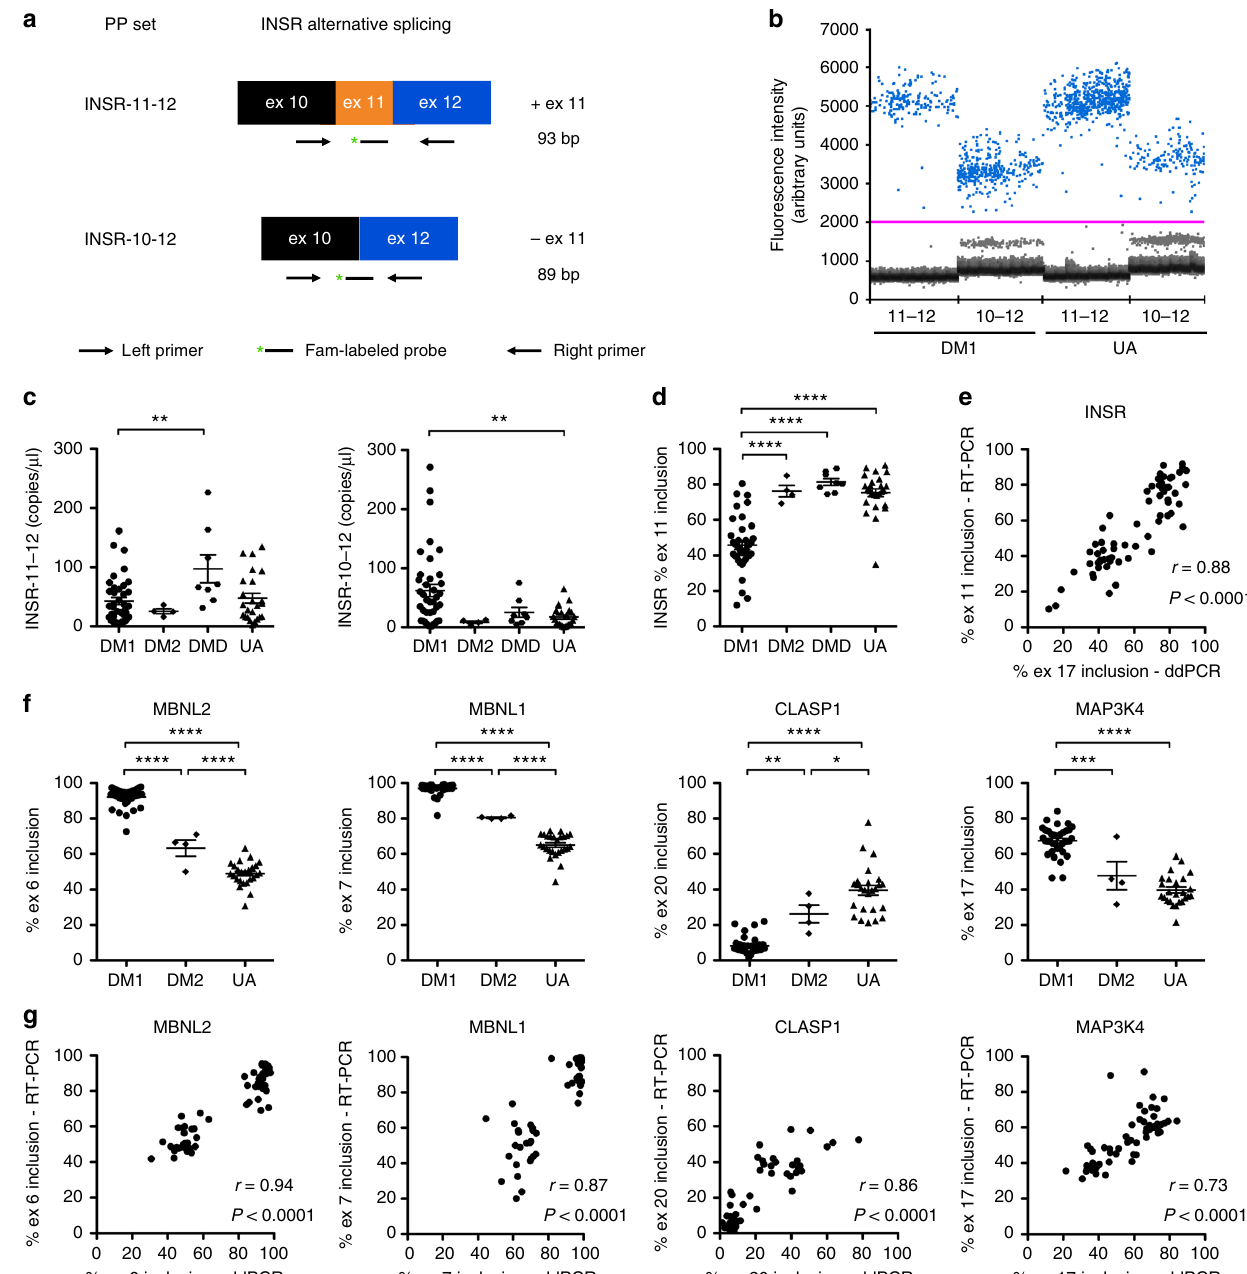
Fig. 5 Droplet digital PCR (ddPCR) analysis of alternative splicing in human urine exRNA. We used ddPCR to examine splicing of INSR exon 11 in urine exRNA samples from DM1 ( N = 37), DM2 ( N = 4), DMD/BMD ( N = 8), and UA controls ( N = 25). a Assay design using separate primer probe (PP) sets to identify exon 11 inclusion (INSR-11-12; amplicon size 93 base pairs, “ bp ” ) and exon 11 exclusion (INSR-10-12; amplicon size 89 bp). b Representative droplet populations in urine exRNA samples from DM1 and UA subjects ( N = 4 each) using each assay (INSR-11-12 and INSR-10-12). c Quanti fi cation of INSR splice products that include exon 11 (left) and exclude exon 11 (right) as copies per microliter cDNA. Individual data points represent the mean of duplicate assays for each sample. Error bars indicate mean ± s.e.m. ** P = 0.0015 (DM1 vs. UA); * P = 0.01 (DM1 vs. DMD). d Calculation of INSR exon 11 inclusion using data in c . Error bars indicate mean ± s.e.m. **** P < 0.0001 (DM1 vs. DMD/BMD) and (DM1 vs. UA) groups. e INSR exon 11 inclusion measured by ddPCR ( x -axis) vs. RT-PCR ( y -axis) in all subjects. The correlation coef fi cient r and P value are shown. f Exon inclusion percentages for MBNL2 exon 6, MBNL1 exon 7, CLASP1 exon 20, and MAP3K4 exon 17. Error bars indicate mean ± s.e.m. **** P < 0.0001 (all four transcripts, DM1 vs. UA), ( MBNL2 and MBNL1 , DM1 vs. DM2), and, ( MBNL1 , DM2 vs. UA); *** mean difference 14.2, 95% CI of difference 6.2 – 22.1 ( MBNL2 , DM1 vs. DM2), and mean difference 20.1, 95% CI of difference 9.0 – 31.2, ( MAP3K4 , DM1 vs. DM2); ** mean difference 17.9, 95% CI of difference 5.5 – 30.3, ( CLASP1 , DM1 vs. DM2); * mean difference 13.2, 95% CI of difference 0.4 – 26.4, ( CLASP1 , DM2 vs. UA); one-way ANOVA. g Exon inclusion of MBNL2 , MBNL1 , CLASP1 , and MAP3K4 measured by ddPCR ( x -axis) vs. RT-PCR ( y -axis) in all subjects. The correlation coef fi cient r and P values are